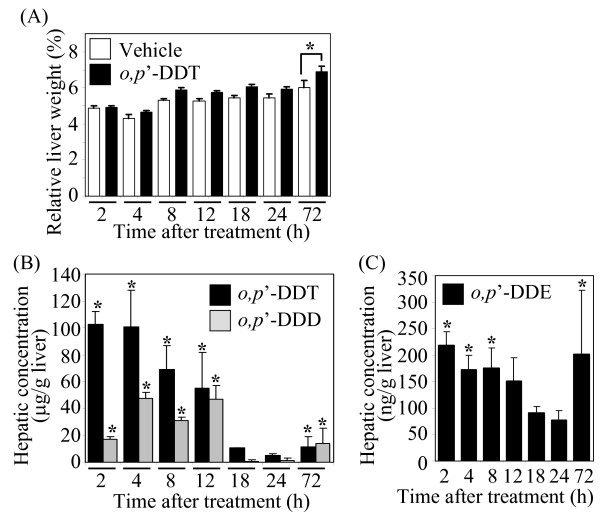
Relative liver weight and tissue level analysis. (A) Relative liver weight. Immature ovariectomized C57BL/6 mice were orally administered 300 mg/kg o, p'-DDT or sesame oil vehicle at time 0, 24 and 48 h. Mice were sacrificed 2, 4, 8, 12, 18, 24 or 72 h after the initial dose. The relative liver weight was significantly increased at 72 h. (B) Hepatic concentration of o, p'-DDT and o, p'-DDD. (C) Hepatic concentration of o, p'-DDE. Hepatic tissue levels of o, p'-DDT, o, p'-DDD and o, p'-DDE were determined using high-resolution gas chromatograph/HRMS from three randomly selected mice orally gavaged with 300 mg/kg o, p'-DDT. The data are presented as mean ± SE. The asterisk (*) indicates a significant (p < 0.05) difference from the vehicle controls.